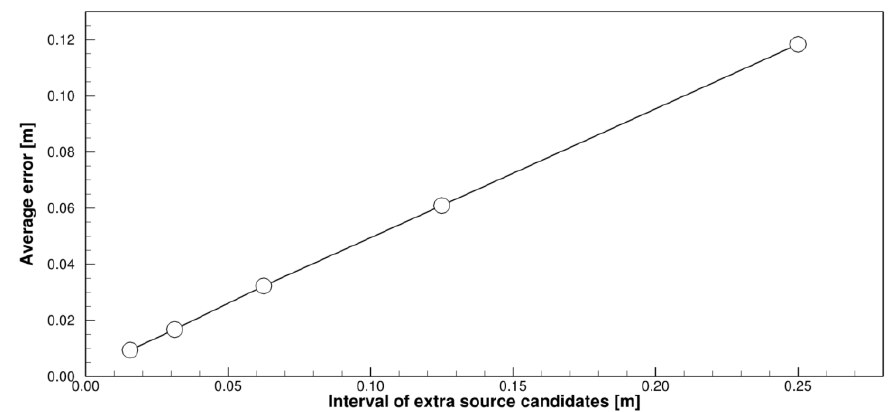
Figure 7. Interval of extra source candidate vs. average error of identified source